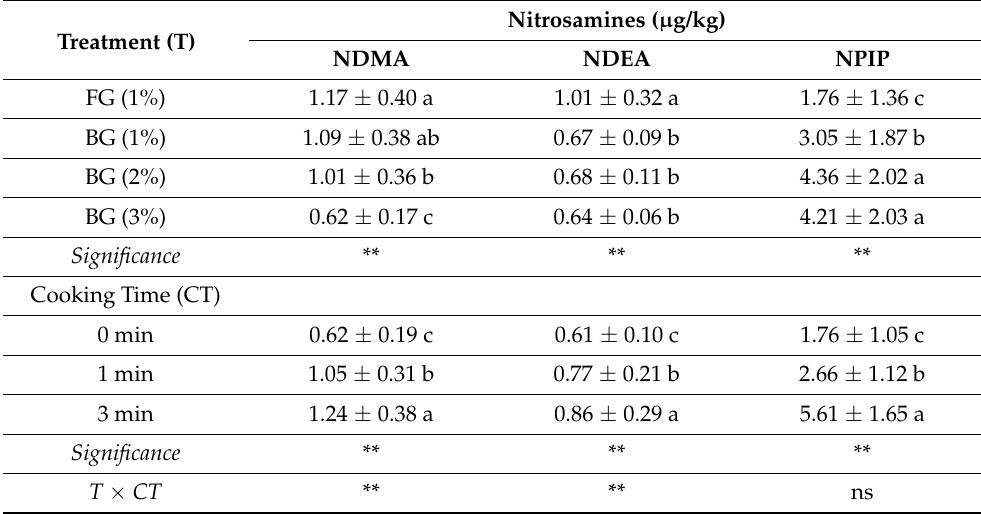
Table 3. The overall effects of garlic treatment and cooking time on color value and the nitrosamine contents of heat-treated sucuk (mean ±